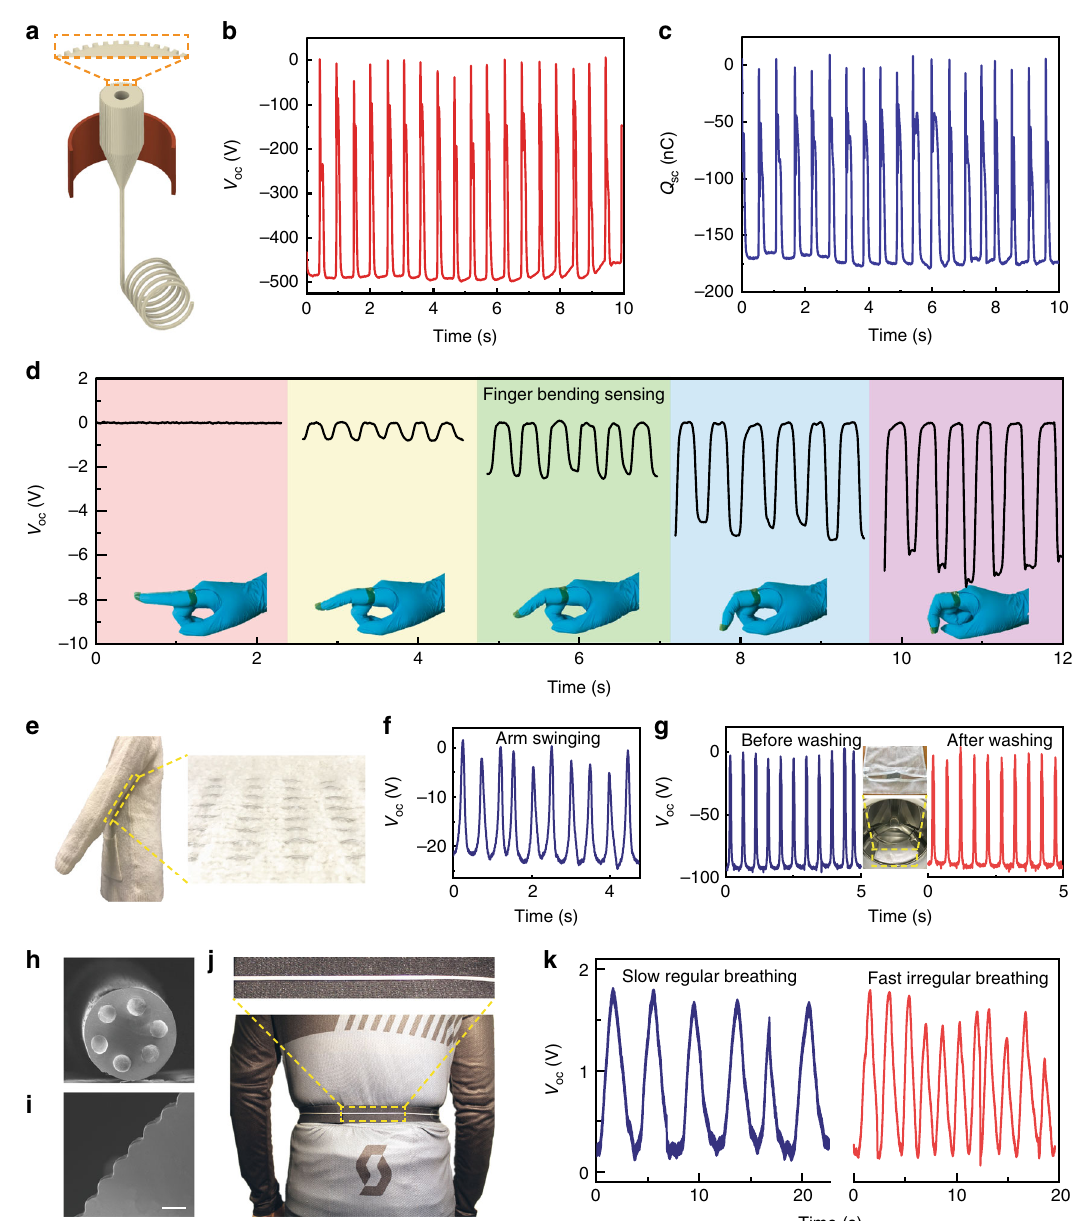
Fig. 4 Triboelectric fi bers and textiles for wearable applications. a Schematic of the thermal drawing of a microtextured soft fi ber. b , c The recorded V oc and Q sc of a 6 cm × 6 cm textile made up of a long microtextured fi ber, under the applied force of 25.5 N (7.1 kPa). d Demonstration of the fi bers as self- powered sensors to monitor fi nger-bending conditions. e , f Photographs and the corresponding V oc of a triboelectric fi ber-integrated sweater to extract energy from human arm swing. g Comparison of the voltage output of the textile before and after being washed in a laundry machine. The inset image shows a water-permeable protective sack with the textile placed in a household laundry machine. h – j Breathing monitoring with a self-powered triboelectric wearable sensor. The fi ber features six embedded electrodes ( h ) and a microtextured surface ( i ) for improved performance. The fi ber is fi xed on a stretchable belt, which is worn around the torso ( j ). k The generated waveforms allow the quantitative assessment of breathing patterns. Scale bars: h 200 μ m, i 10 μ Methods Fabrication of triboelectric fi bers . The hollow-core cylindrical preforms were Polymer comparison . The commonly used insulative thermoplastic polymers for fabricated by consolidating Geniomer granules (140, Wacker Chemie AG) within molds at 175°C in a vacuum-consolidation oven. The length and diameter of the thermal drawing were compared using the metrics of Young ’ s modulus and relative preform are 120mm and 29mm, respectively. The microtextured Geniomer pre- triboelectric polarity. The value of Young ’ s modulus for Geniomer was experi- forms were created by rolling a thin layer of Geniomer fi lm with prede fi ned texture mentally determined from mechanical tensile tests, while the other polymers were onto the above-mentioned cylindrical preforms, followed by consolidation at 170°C directly taken from corresponding data sheets or from literature 36 . The triboelectric for 15min under vacuum. The fabrication of the microtextured Geniomer fi lm is as polarity of the materials was determined from the electrical outputs of a series of follows. Micropatterns with the de fi ned period of 100 μ m were created on silicon self-constructed contact-mode 2D TENG devices with the selected polymer fi lms as masks via photolithography process at the Centre for Micro-Nanofabrication (CMi) the dielectric surfaces (Supplementary Fig. 18).